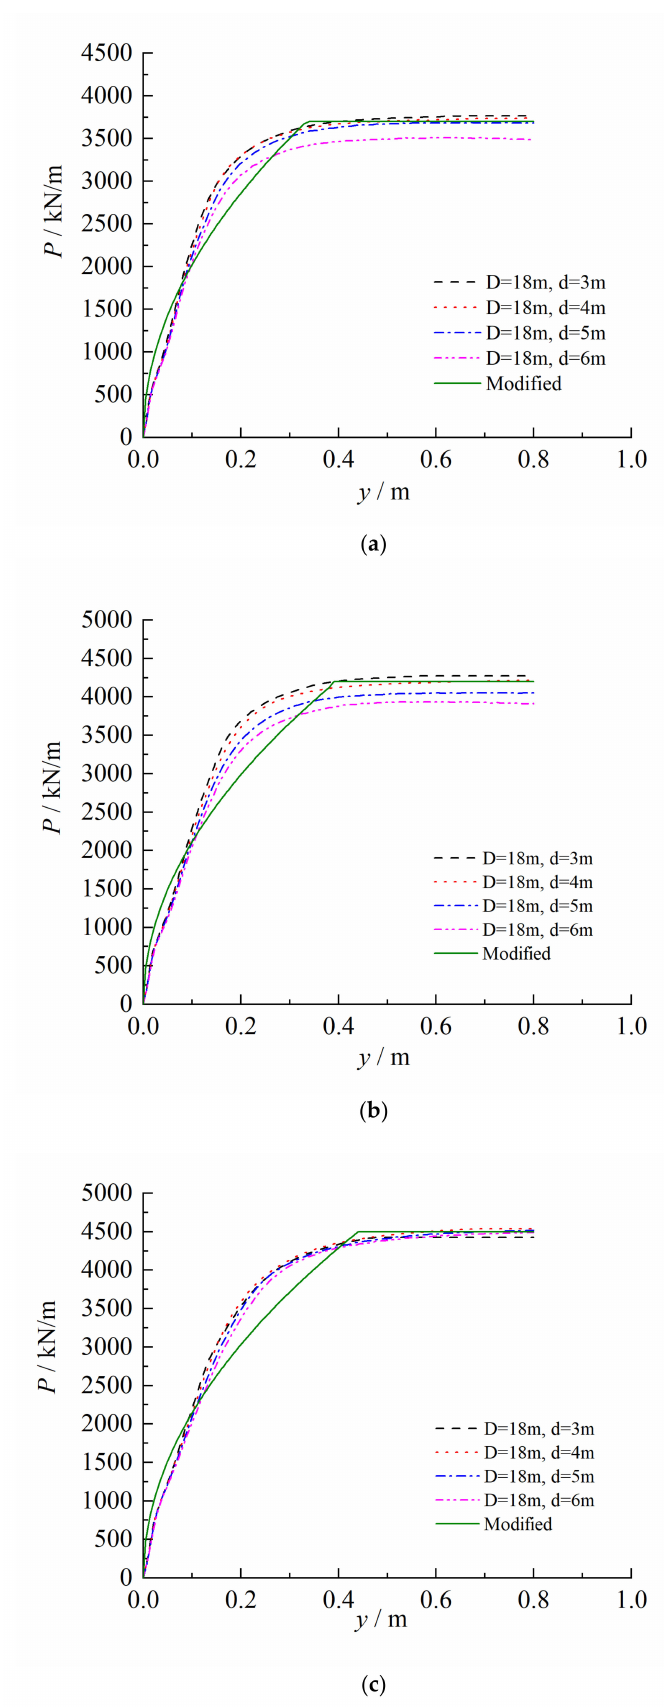
Figure 19. Modified p - y curve. ( a ) Depth of 2.25 m. ( b ) Depth of 3.75 m. ( c ) Depth of 5.25